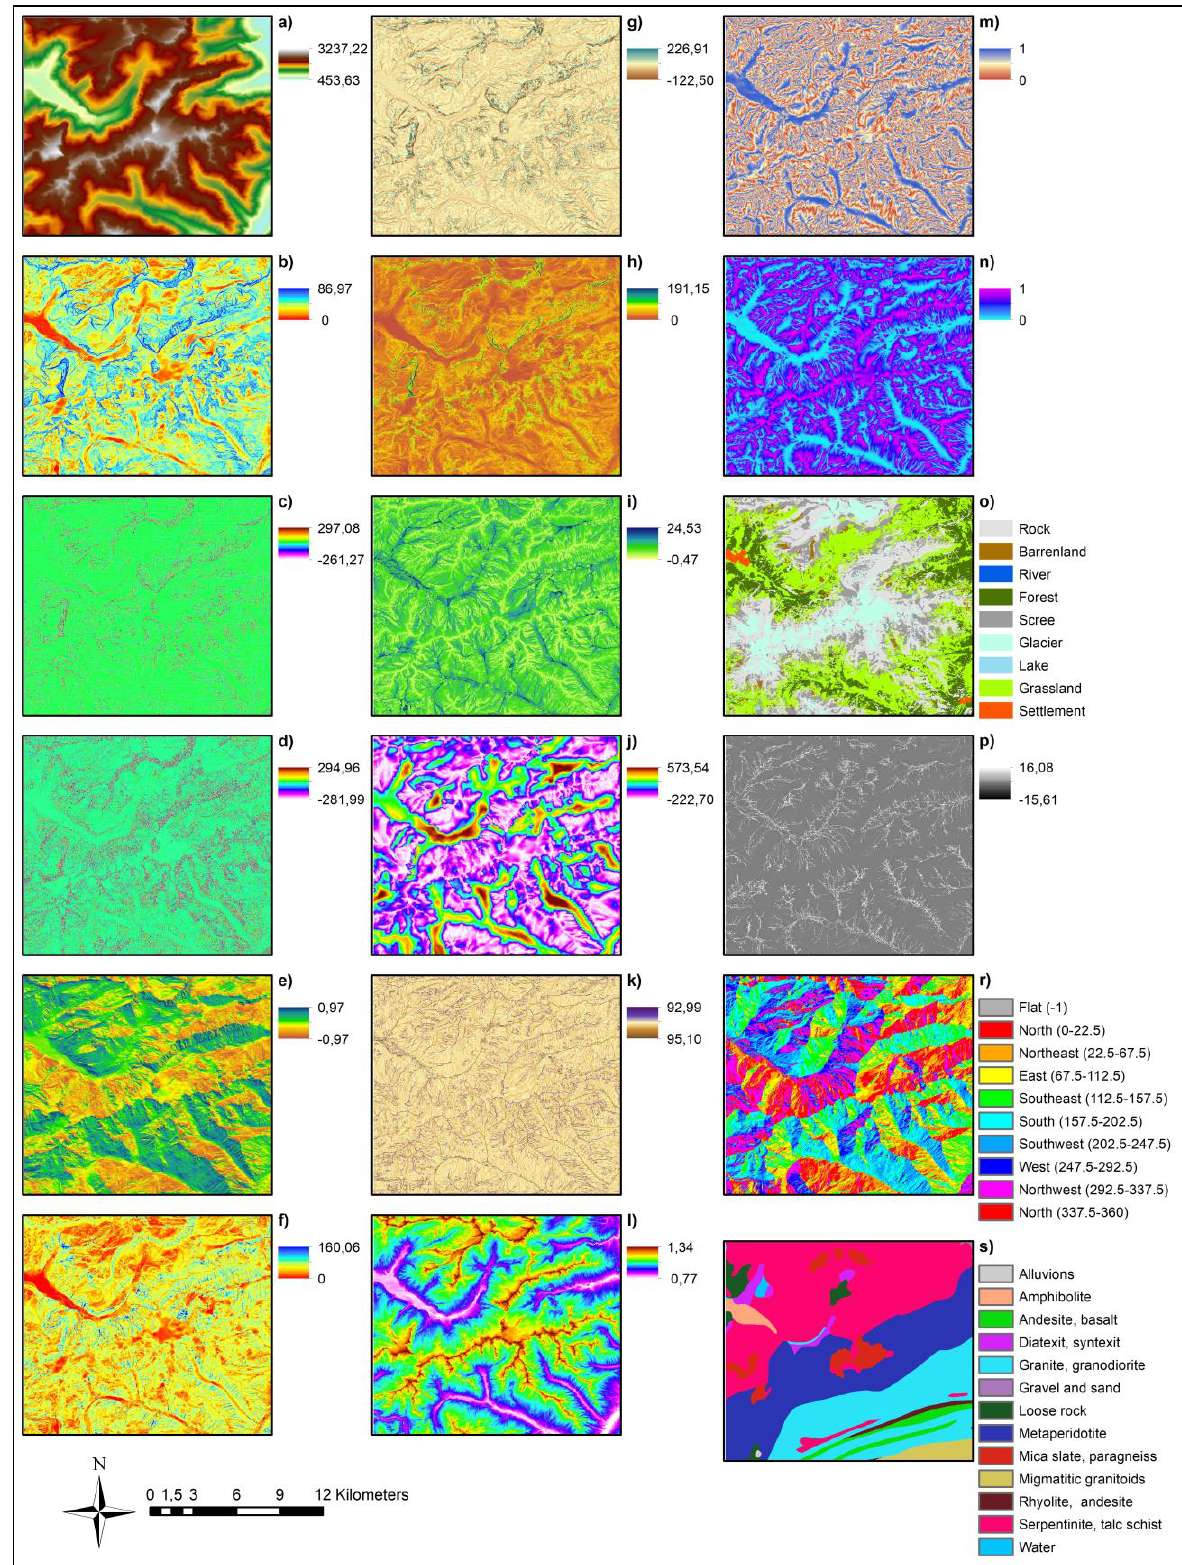
Figure A1 . Conditioning factors: a) elevation, b) slope, c) profile curvature, d) plan curvature, e) diurnal anisotropic heating